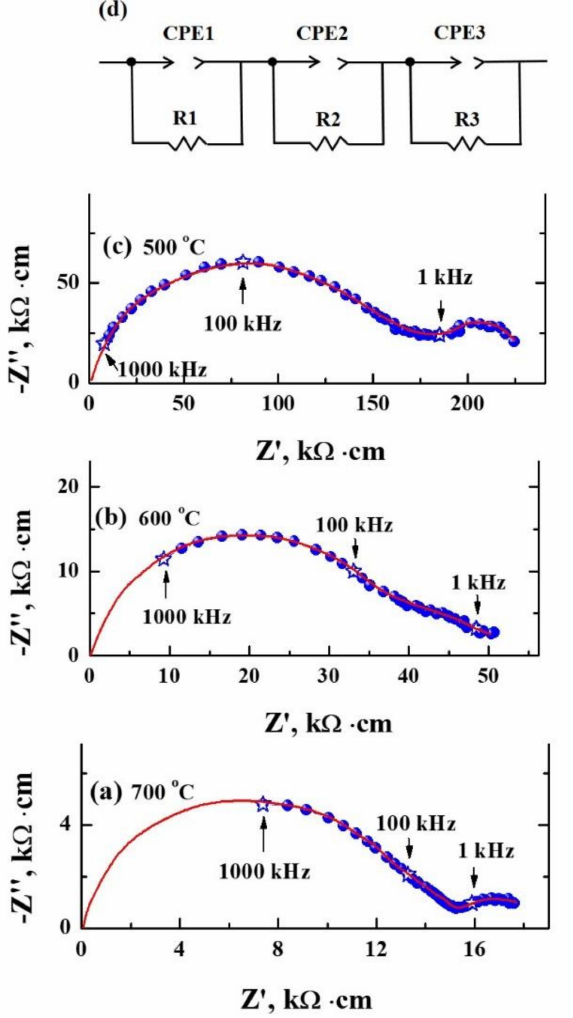
Figure 3. The Nyquist-plots obtained at the different temperatures under dry air for the composition BaLa 2 In 2 O 7 : ( a ) 700 ◦ C, ( b ) 600 ◦ C, ( c ) 500 ◦ C, and ( d ) the equivalent circuit of fitting (red